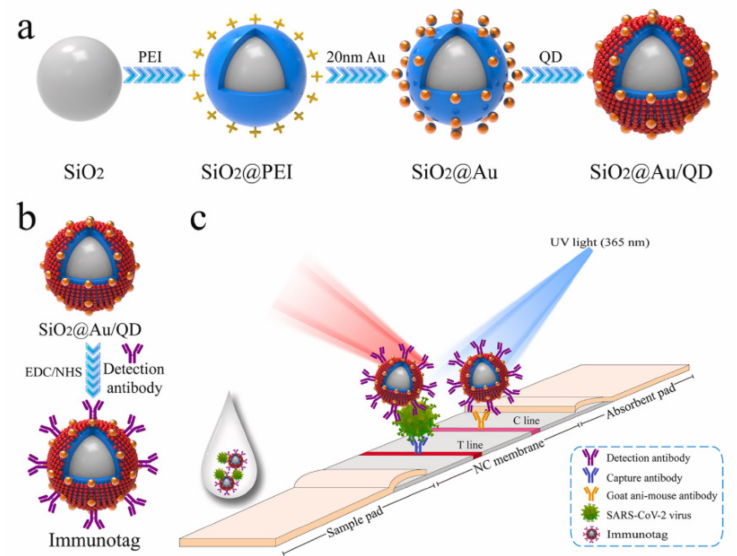
Figure 4. A schematic representation of a fabrication process for dual-functional SiO 2 @Au/QD fluorescent labels ( a , b ) with colorimetric and fluorescent functionality to detect the SARS-CoV-2 S1 protein by dual modes of naked eye / fluorescence ( c ). Reproduced with consent from